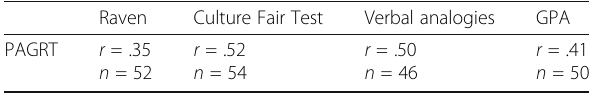
Table 4 Correlations between the PAGRT and external criteria Raven Culture Fair Test Verbal